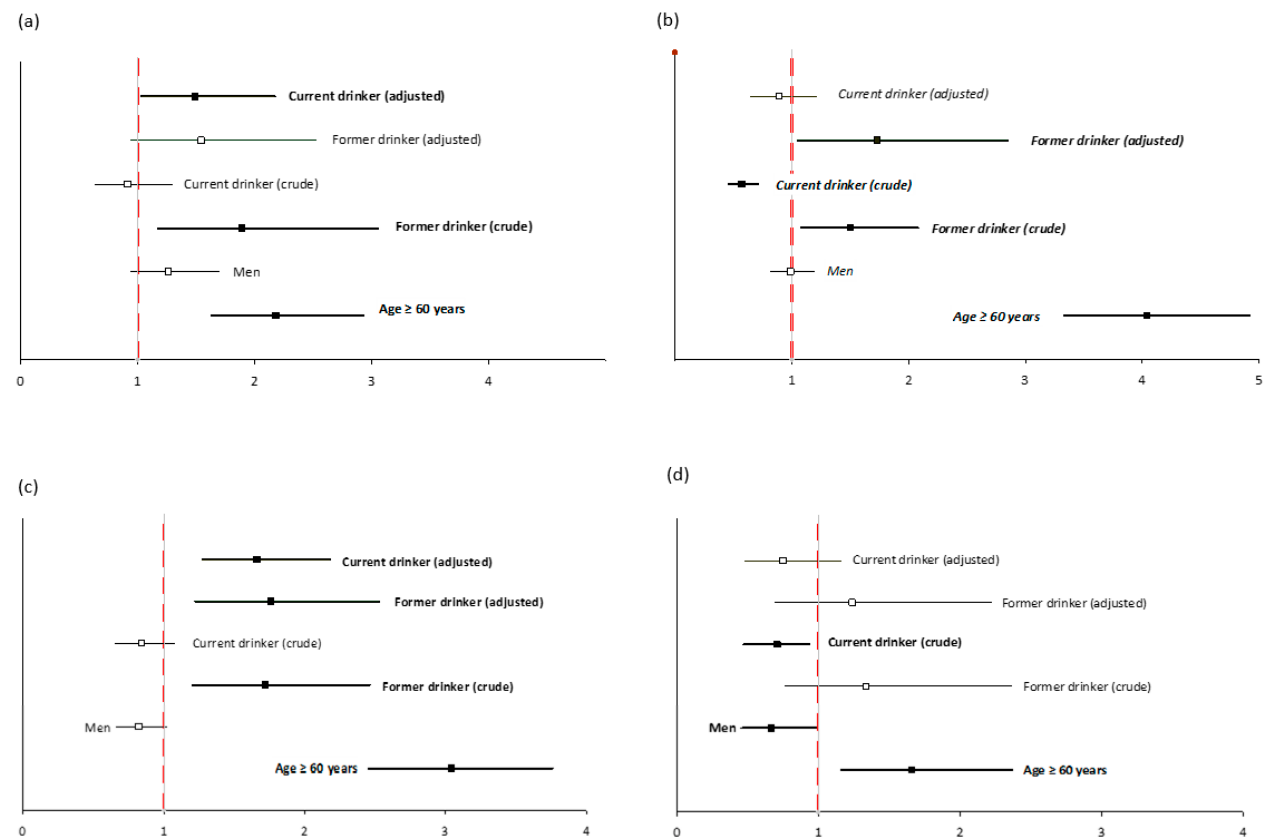
Figure 3. The odds ratio (with 95% CI) for occurrence of diabetes ( a ), hypertension ( b ), CVD ( c ), and hepatitis or jaundice ( d ) in groups of participants differentiated by attitudes toward alcohol consumption ((crude)—unadjusted OR; (adjusted)—attitudes toward alcohol consumption have been adjusted to age).